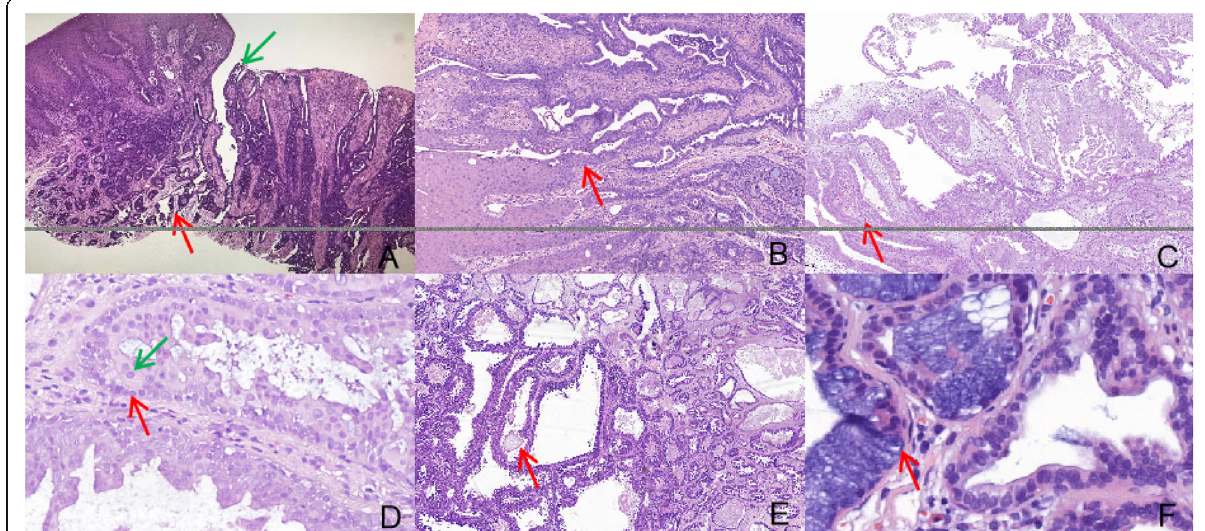
Fig. 3 Pathological manifestations of Sialadenoma papilliferum. a SP shows a biphasic growth pattern with an exophytic papillary component surfaced by a keratotic squamous epithelium (Green arrow) and an endophytic adenomatous component of the underlying lesion (Red arrow) (20x). b Papillary frond surfaced by stratified squamous epithelium is contiguous with columnar ductal epithelium (Red arrow) (100x). c The surface papillary structure of the lumen supported by thin fibrovascular core often protrudes into the lumen (Red arrow) (50x). d The ductal lumen is double-layered, lined by luminal cuboidal to columnar cells (Green arrow) and cuboidal to flattened basal cells (Red arrow) (400x). e Localized enlargement of the cyst and eosinophilic deposition in the lumen (Red arrow) (50x). f Mucinous cells in tumour area (Red arrow)